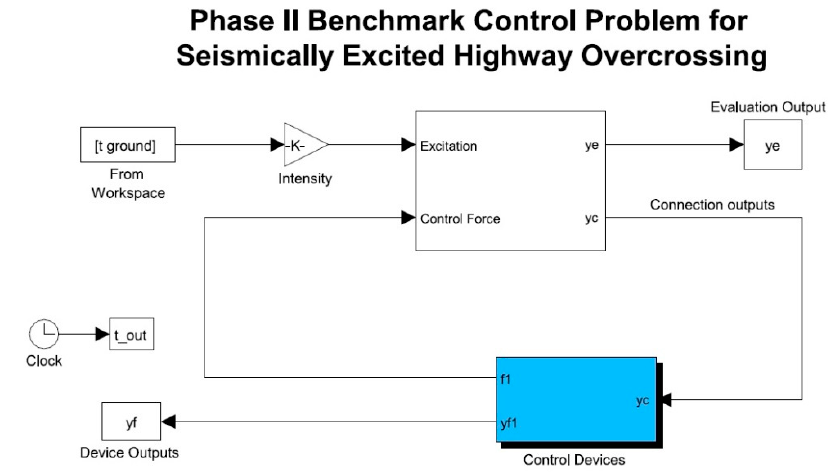
Figure 2. Passive Simulink model of the benchmark bridge.